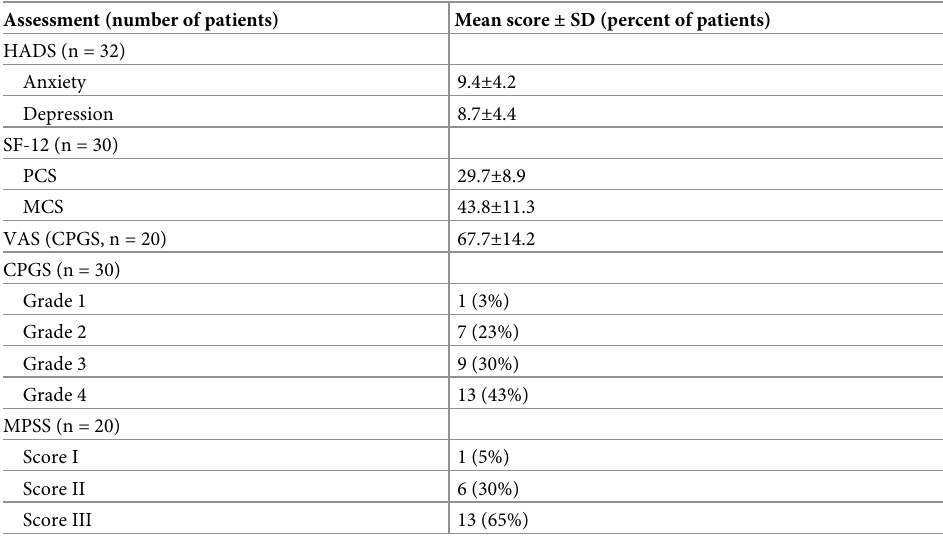
Table 3. Questionnaire scores (HADS, SF-12) and pain scales (GCPS, MPSS) of the